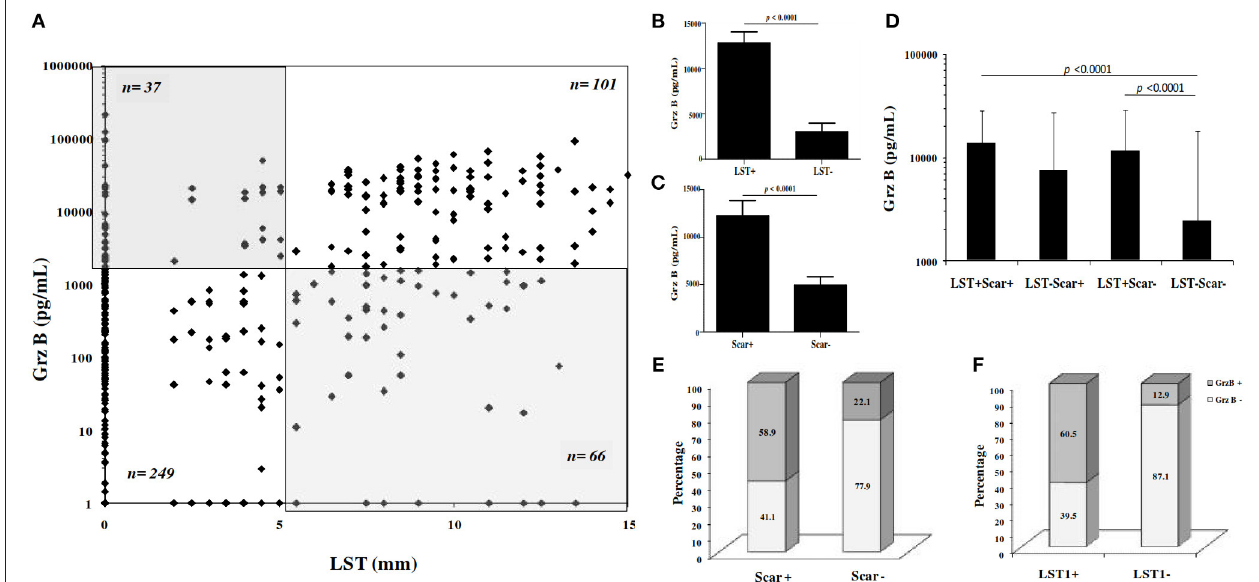
FIGURE 4 | Association between granzyme B levels, LST reactivity and presence of typical ZCL scar. (A) Grz B level expressed in function of result of LST. n number of individual for each group. (B–D) Histograms represent mean values of Grz B levels measured in culture supernatants of PBMCs from individuals, categorized basing on categorical results of LST (LST + /LST − ) and presence or absence of ZCL scars (scar + /scar − ). (E,F) Categorial result for Grz B expression within individuals categorized basing on LST results (LST + /LST − ) or presence or absence of scar (scar + /scar − ). Grz B + : Grz B levels ≥ 2ng/ml, Grz B − : Grz B levels < 2ng/ml. LST + , Diameter of induration ≥ 5mm; LST − , Diameter of induration < 5mm.